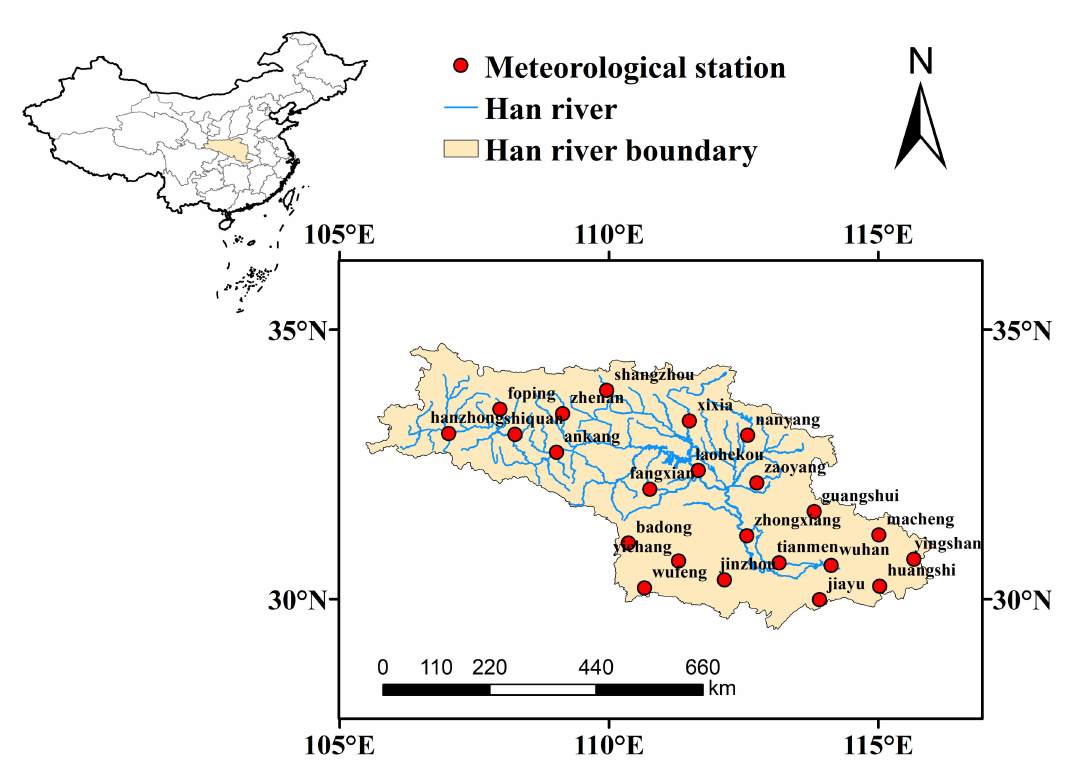
Figure 1. Locations of the study area and the distribution of meteorological